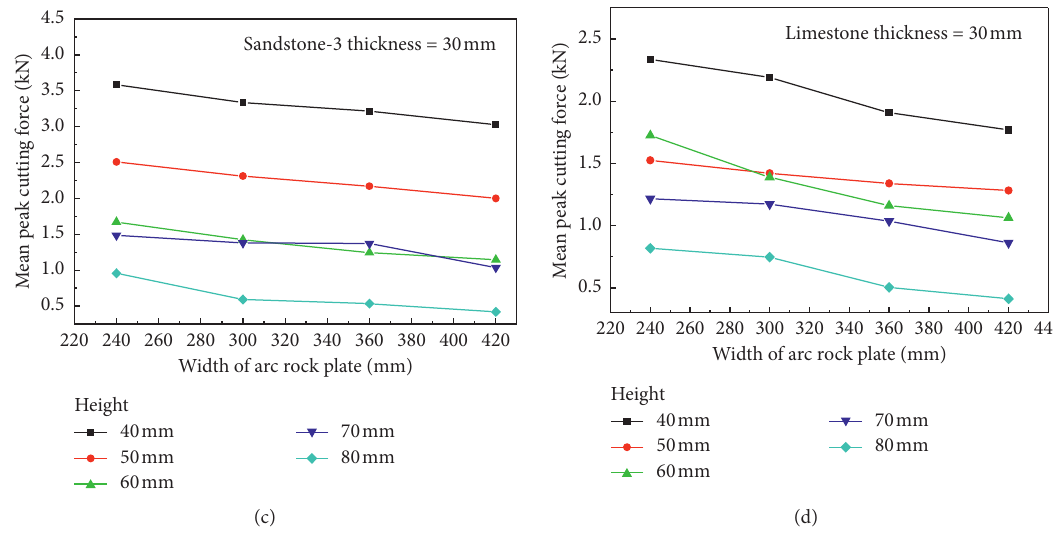
Figure 14: The variation of mean peak cutting force with width of arc rock plate for different rock